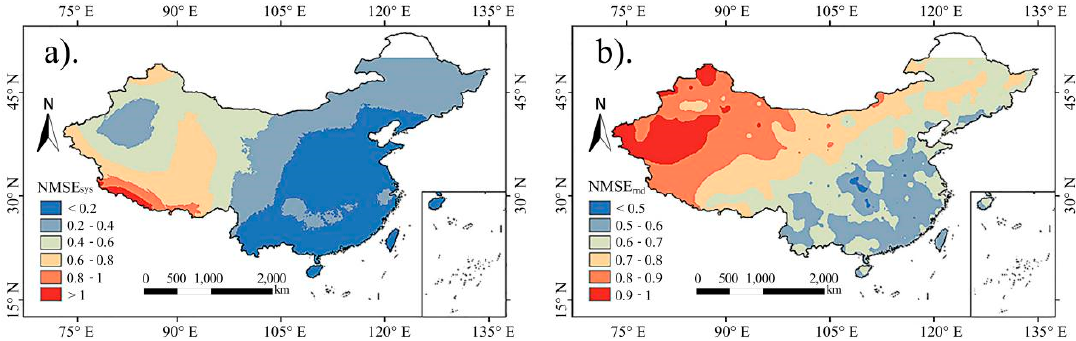
Figure 5. Spatial distribution of the NMSE at the daily ( a ) and monthly ( b ) scale of the 3B42V7 data in mainland China.